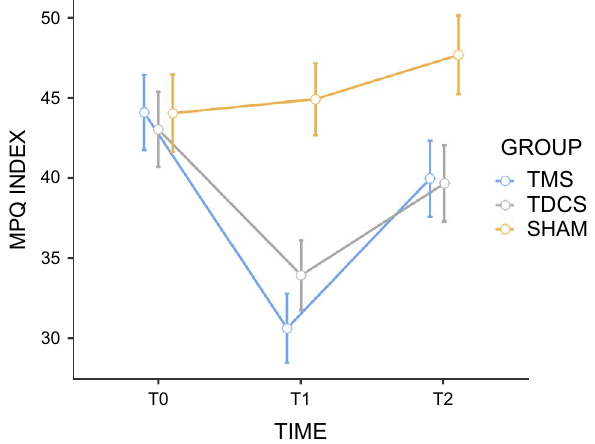
Figure 5. Effects of active repetitive transcranial magnetic stimulation (rTMS), active transcranial direct- current stimulation (tDCS), and sham stimulation on average multidimensional aspect of pain (MPQ). The scores were obtained before the first stimulation session (T0), after the 5th consecutive stimulation session (T1) and 30 days after (T2). For the sake of simplicity, and as the effects of sham rTMS and sham tDCS were remarkably similar regardless of the order in which they were conducted, we present the mean values grouped into a single sham-stimulation group. Error bars indicate standard error of the mean. MPQ McGill Pain